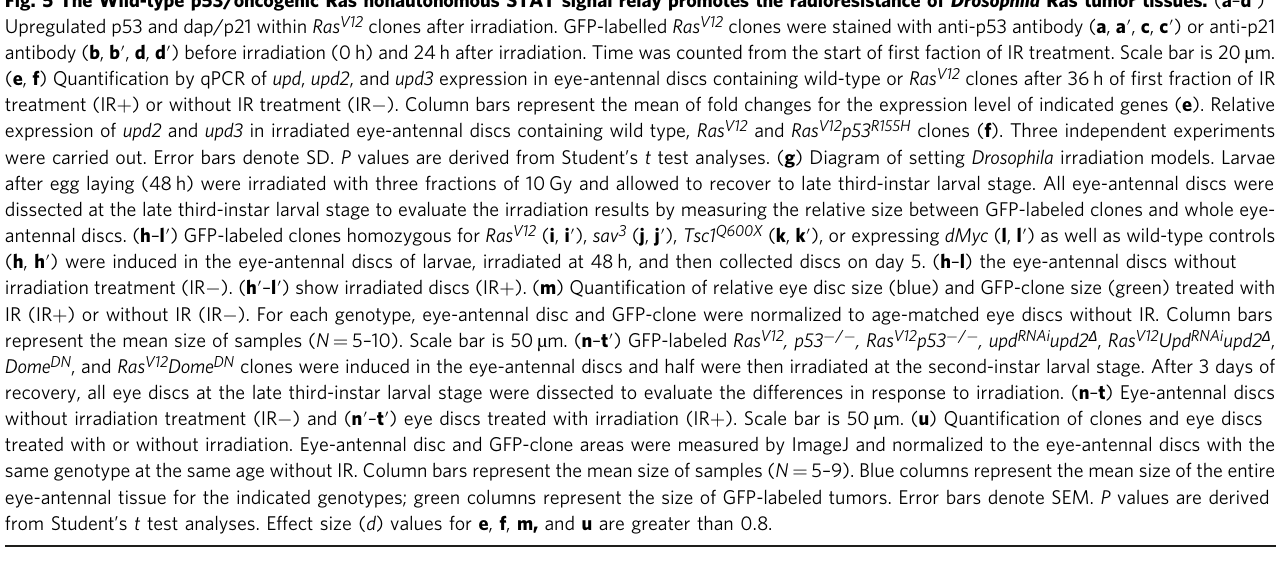
Fig. 5 The Wild-type p53/oncogenic Ras nonautonomous STAT signal relay promotes the radioresistance of Drosophila Ras tumor tissues. ( a – d ′ ) Upregulated p53 and dap/p21 within Ras V12 clones after irradiation. GFP-labelled Ras V12 clones were stained with anti-p53 antibody ( a , a ′ , c , c ′ ) or anti-p21 antibody ( b , b ′ , d , d ′ ) before irradiation (0 h) and 24 h after irradiation. Time was counted from the start of fi rst faction of IR treatment. Scale bar is 20 µ m. ( e , f ) Quanti fi cation by qPCR of upd , upd2 , and upd3 expression in eye-antennal discs containing wild-type or Ras V12 clones after 36 h of fi rst fraction of IR treatment (IR + ) or without IR treatment (IR − ). Column bars represent the mean of fold changes for the expression level of indicated genes ( e ). Relative expression of upd2 and upd3 in irradiated eye-antennal discs containing wild type, Ras V12 and Ras V12 p53 R155H clones ( f ). Three independent experiments were carried out. Error bars denote SD. P values are derived from Student ’ s t test analyses. ( g ) Diagram of setting Drosophila irradiation models. Larvae after egg laying (48 h) were irradiated with three fractions of 10 Gy and allowed to recover to late third-instar larval stage. All eye-antennal discs